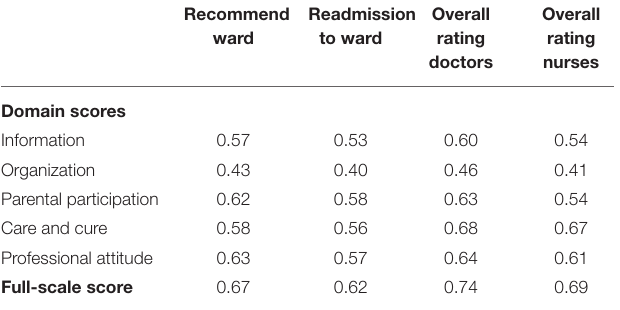
TABLE 5 | Spearman’s rank correlation coefficient between domain scores ( n = 183). Information Organization Parental